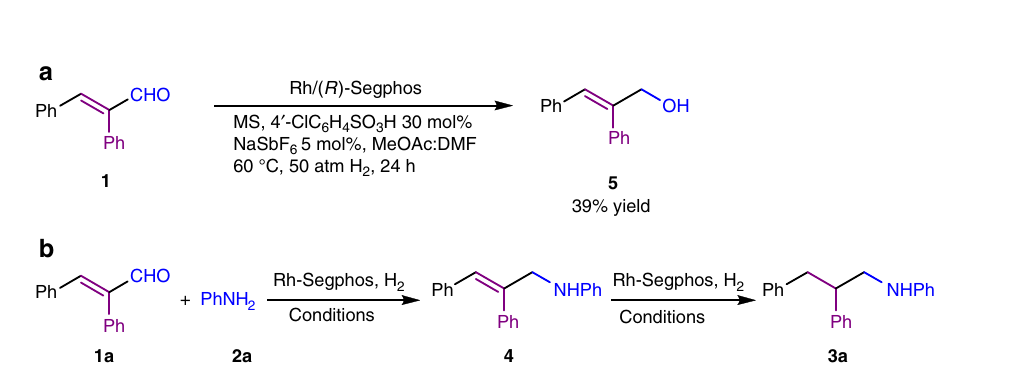
Fig. 2 The order of reduction of C = N and C = C bonds. a The reduction of 1 without the addition of aniline 2a . b The reduction of 1 with the addition of aniline 2a